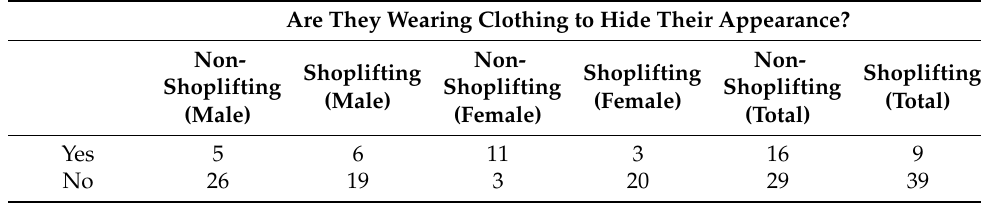
Table 3. Frequency of individuals wearing clothing that may hide their appearance. Are They Wearing Clothing to Hide Their Appearance?